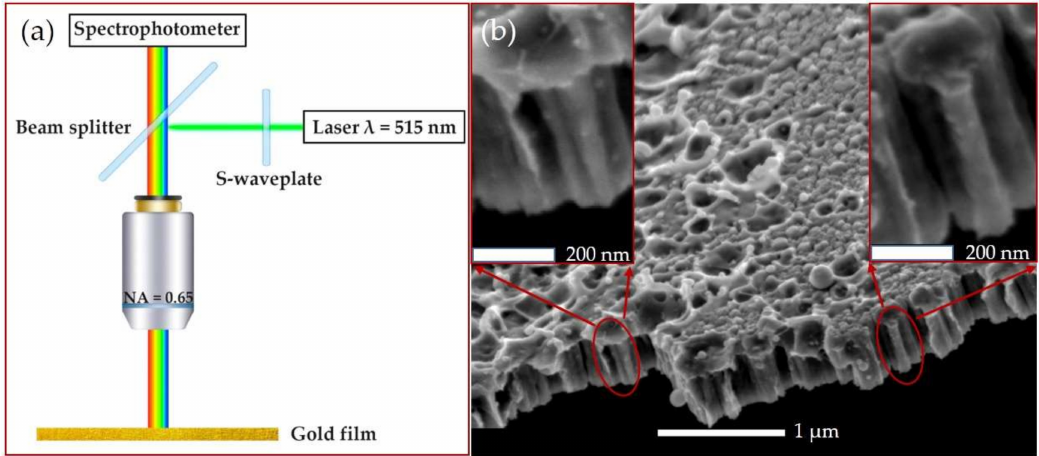
Figure 2. ( a ) The schematic of the experimental setup. ( b ) The SEM side-view image of the gold film inner structure at different magnifications. The nanorod-like element is shown in the red circle.